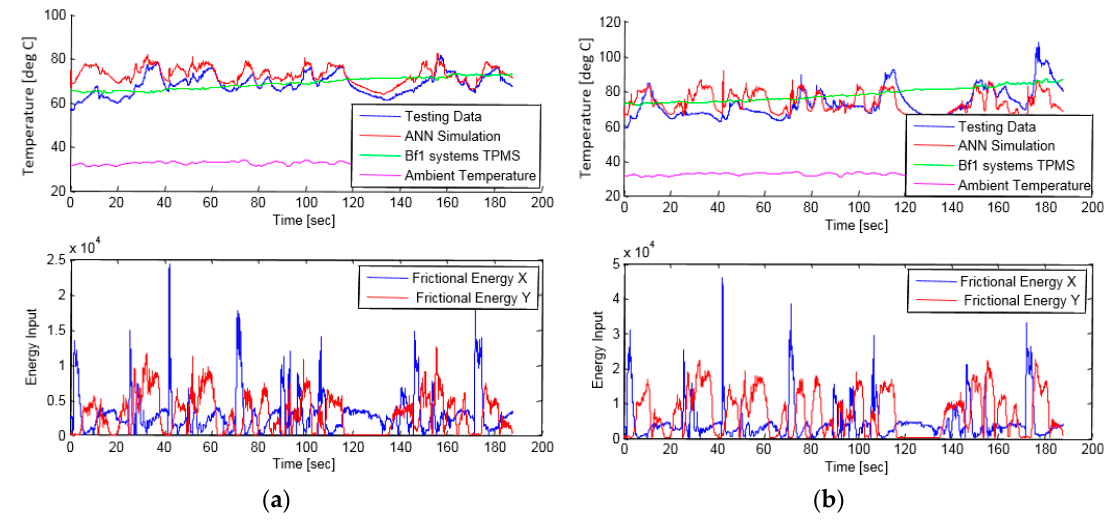
Figure 21. Tire surface temperature prediction results: ( a ) front axle and ( b ) rear axle. ANN = artificial neural network. BF1 = bf1systems Tire Pressure Monitoring System.